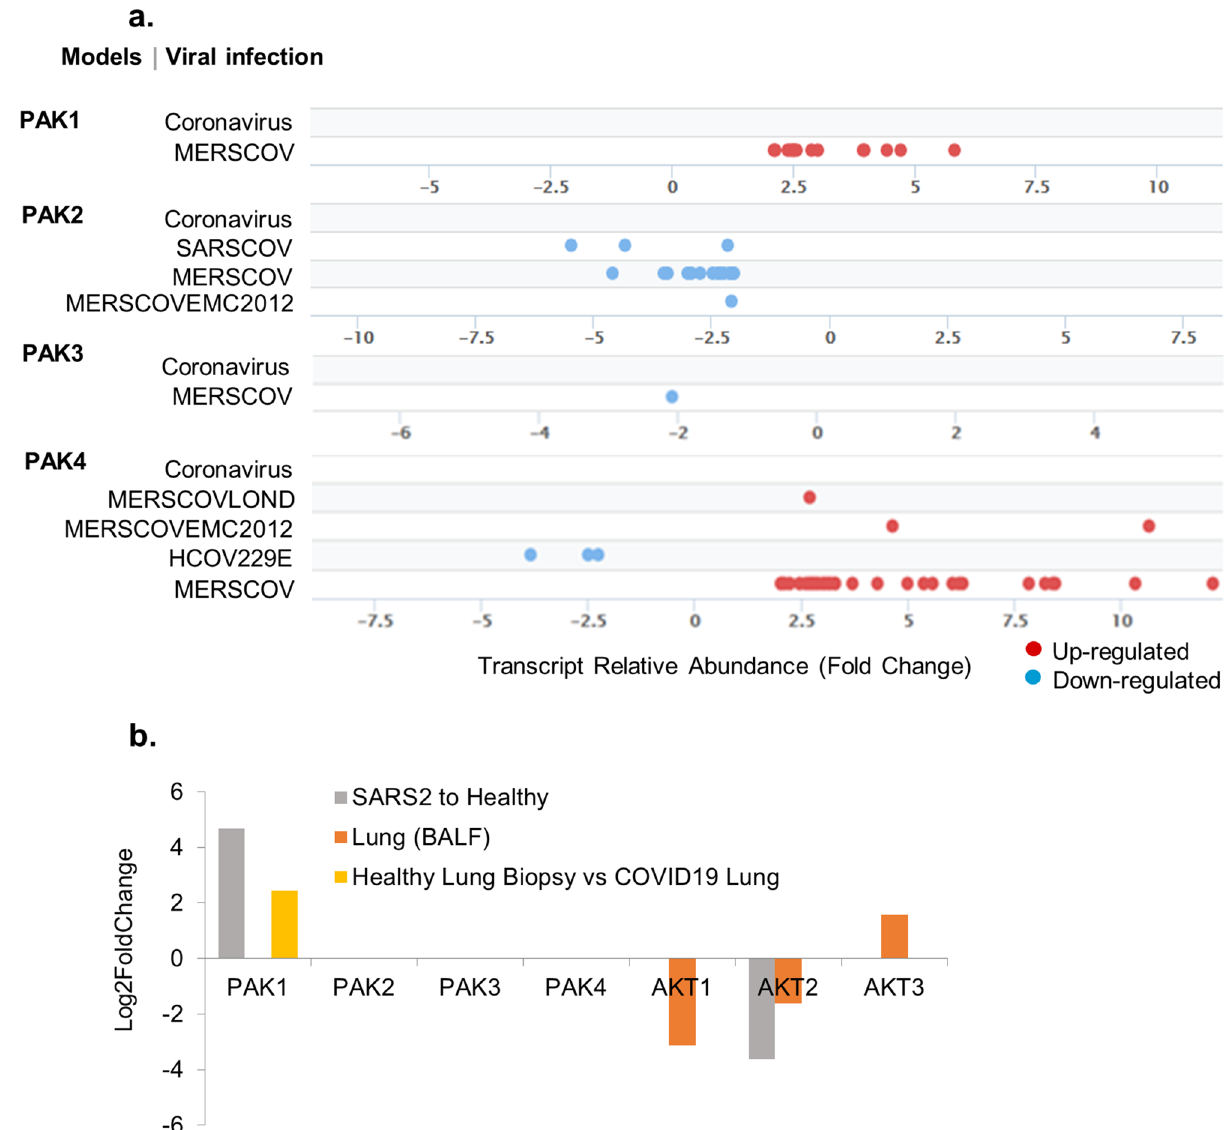
expression levels of kinases in SARS-COV-2 patient